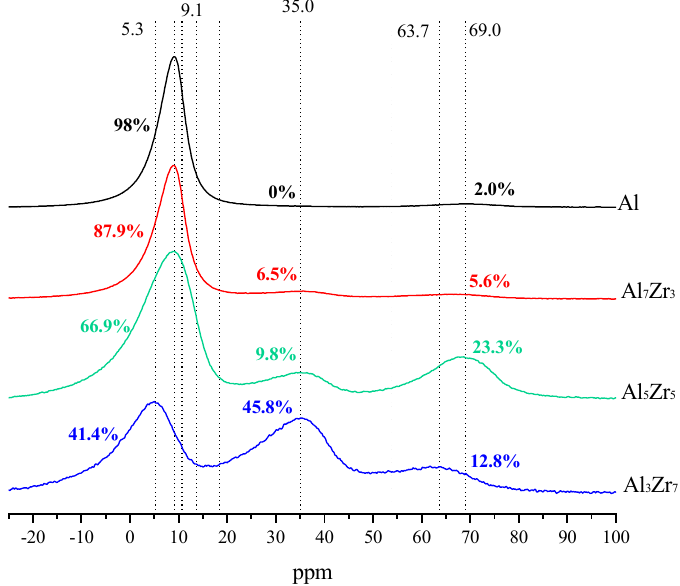
Figure5. 27 Almagicanglespinning-nuclearmagneticresonance(MAS-NMR)ofAlandAl x Zr y Figure 5. 27 Al magic angle spinning-nuclear magnetic resonance (MAS-NMR) of Al and Al x Zr y catalysts.